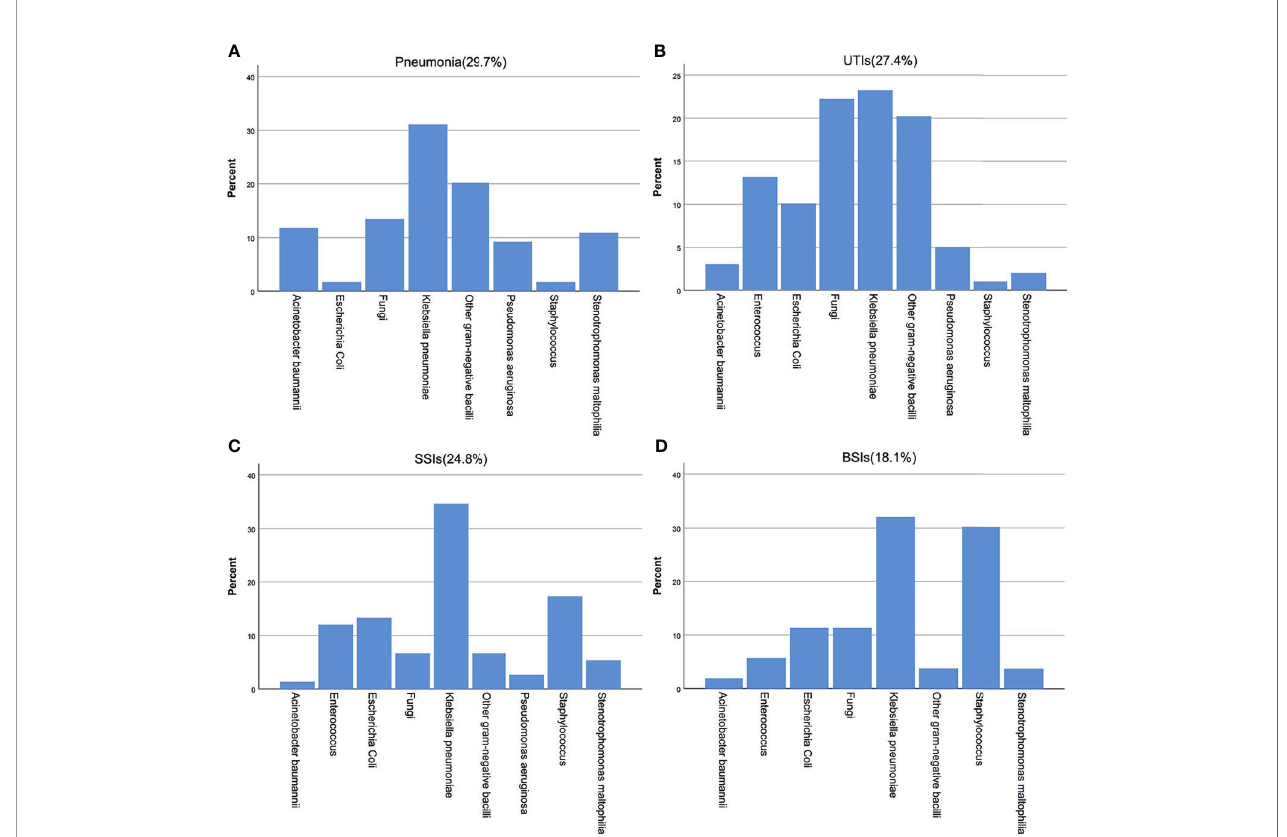
FIGURE 1 | Pathogen distribution at different infected sites after KT. (A) pneumonia, (B) UTIs, (C) SSIs, (D)